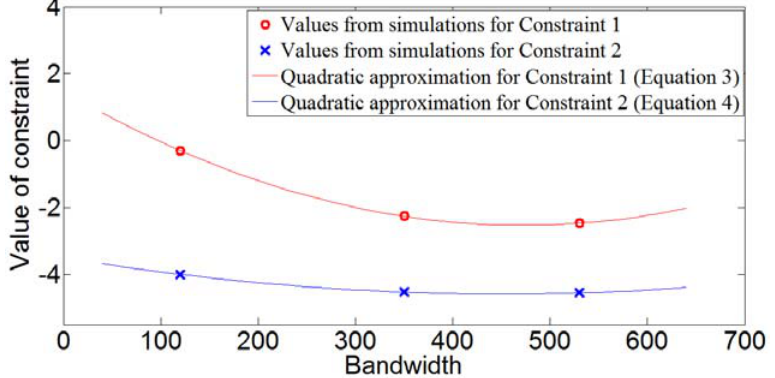
Figure 4. Representation of constraints by quadratic equations.